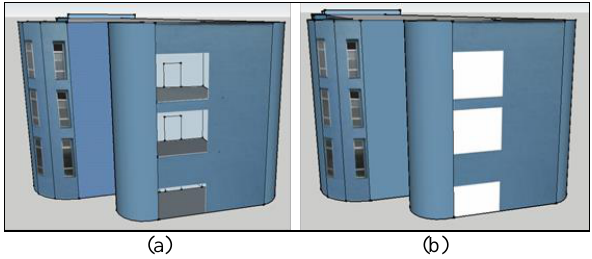
Figure 5. a) Texturing in png format b) Texturing in jpeg